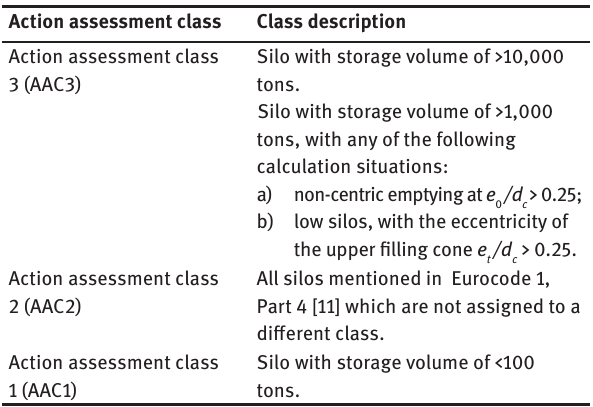
Table 1: Classification of silo action assessment class according to - Eurocode 1, Part 4 [11].